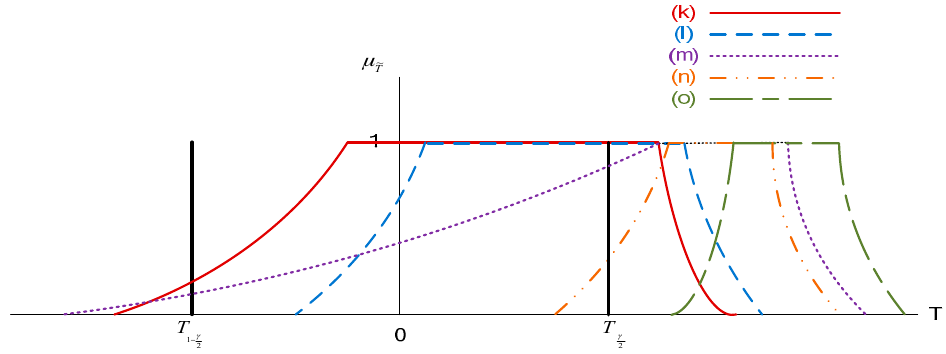
~ ~ ~ for the two-sided test. Figure 7. Right-tended five di ff erent types of membership functions of (cid:101) T for the two-sided for the two-sided test. for the two-sided test.